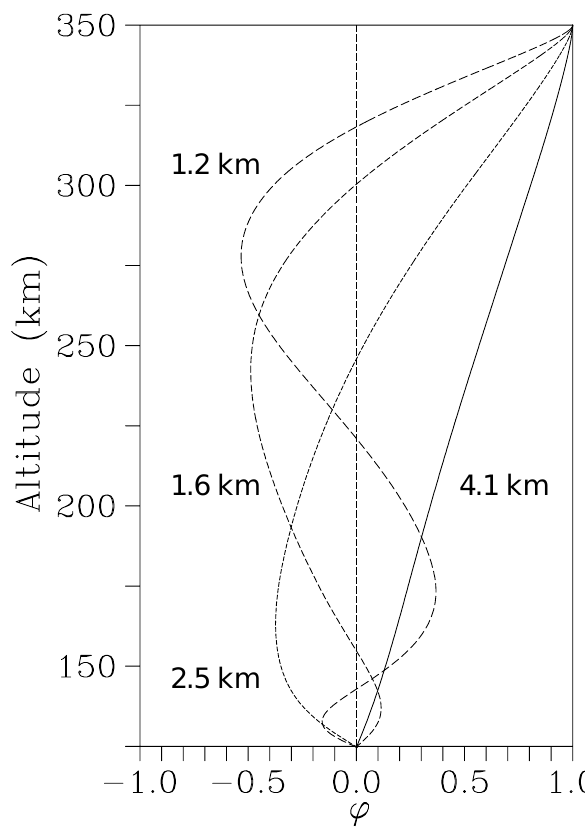
Fig. A1. Mode shapes for the four lowest order eigenmodes. The horizontal axis represents relative electrostatic potential, and the vertical axis represents altitude on a magnetic field line with an apex height of 350km. The relative potential is greatest at the apex point. Labels represent the cutoff wavelengths, 2 π/k ◦ ,